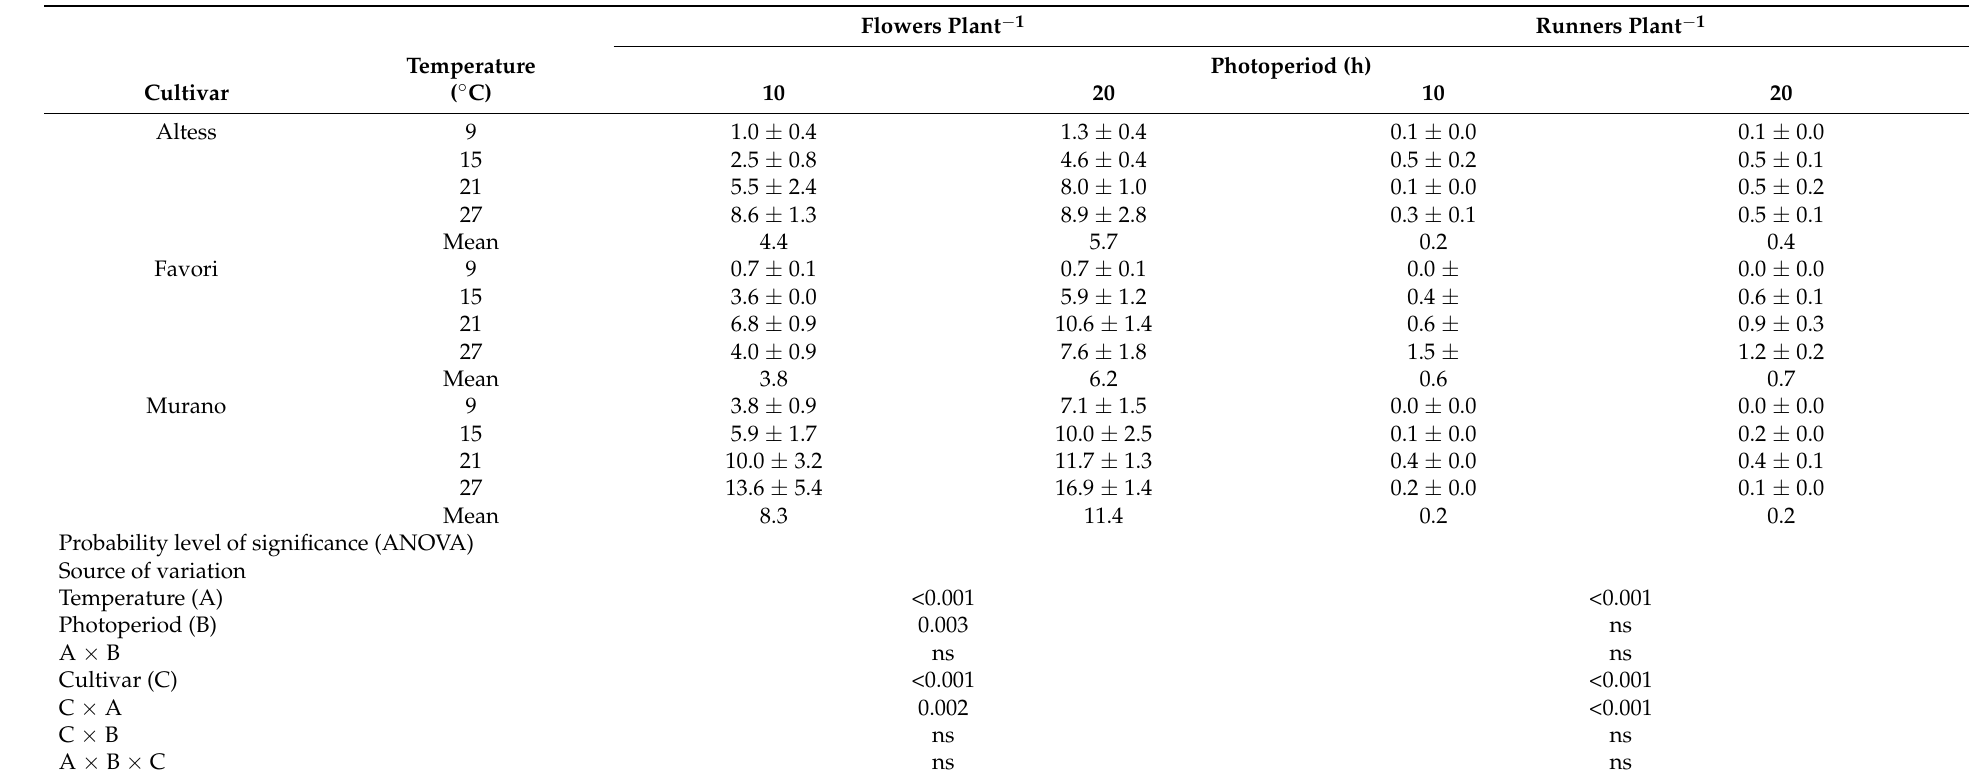
Table 1. Appearances of flowers and runners in three EB strawberry cultivars during the 4-week preconditioning treatment in the phytotron. The data are means ± SD of three replicates, each with 10 plants of each